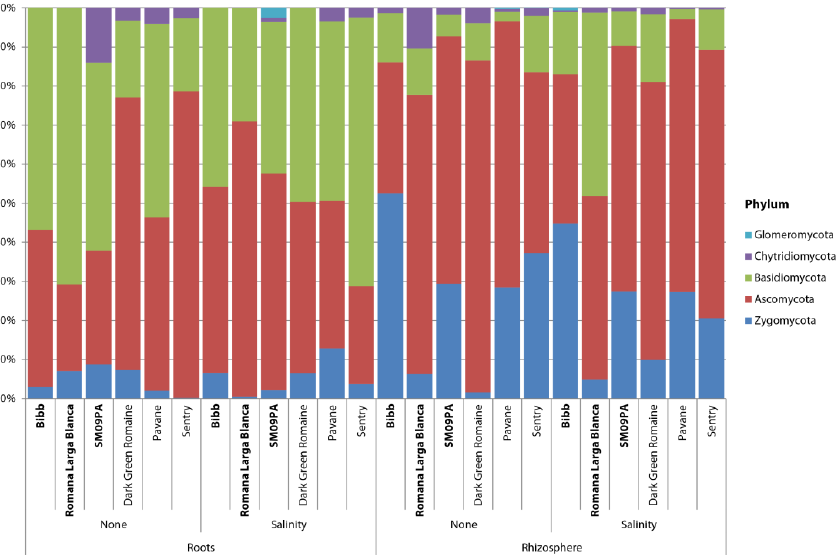
Figure 6. Bar chart of fungal phyla composition in roots and rhizosphere of six lettuce varieties in normal conditions and under salinity stress.